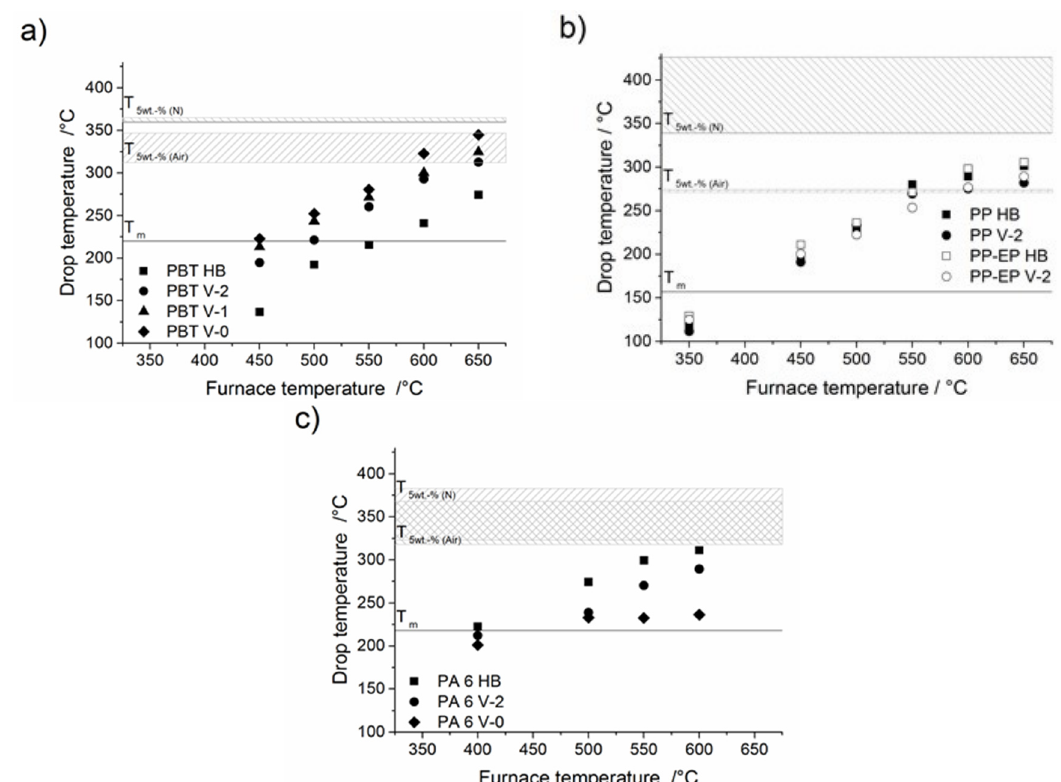
Figure 9. Temperature of drops as a function of furnace temperature with various UL 94 classifications for: ( a ) PBT HB, PBT V-2, PBT V-1, PBT V-0; ( b ) PP HB, PP V-2, PP-EP HB, PP-EP V-2; and ( c ) PA 6 HB, PA 6 V-2, PA 6 V-0.